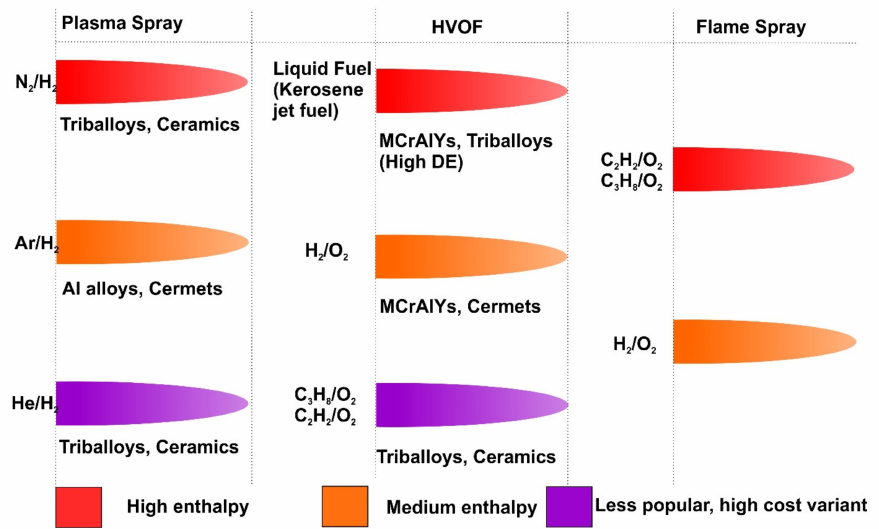
Figure 2. Thermal spray plume showing high, medium, and low enthalpy producing gases, and suitable